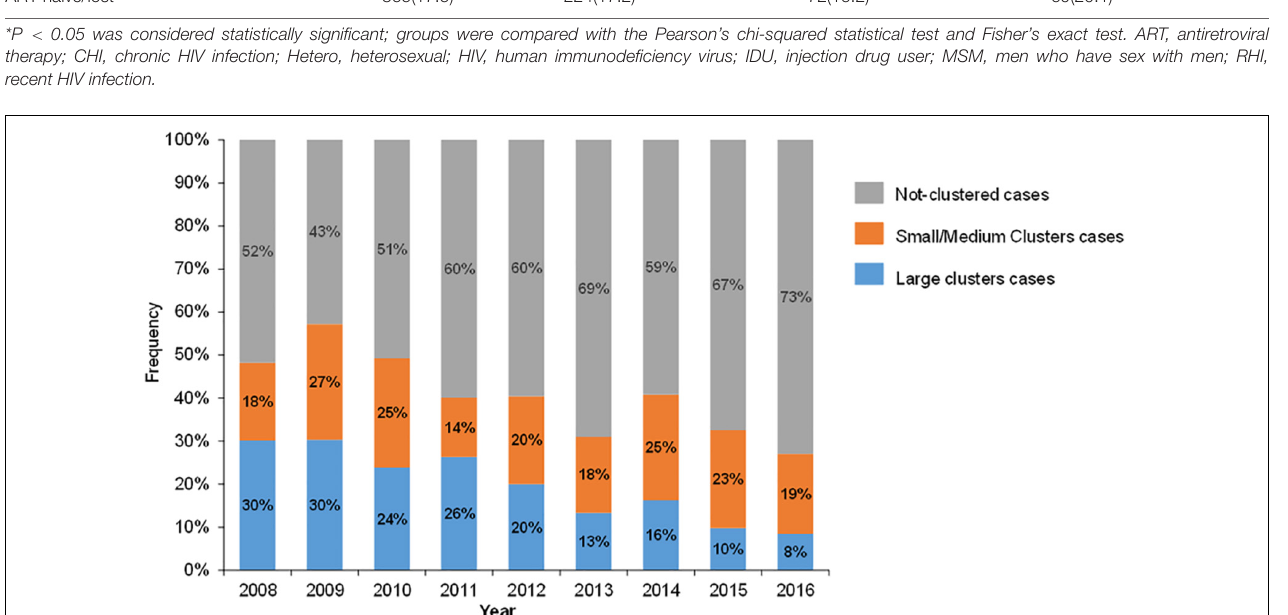
for AE-1, AE-3, and B-2 occurred in 2008, 2009, and 2010, respectively. The R e of all of three clusters declined and remained at 1 for > 5 years, implying that the clusters were historical and have receded in recent